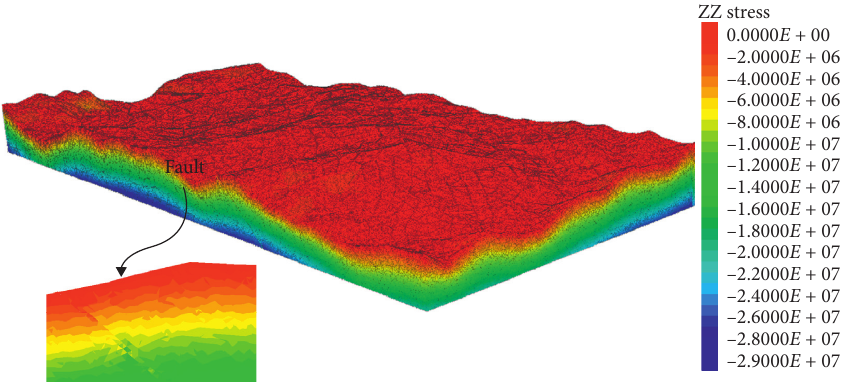
Figure 8: Vertical in situ